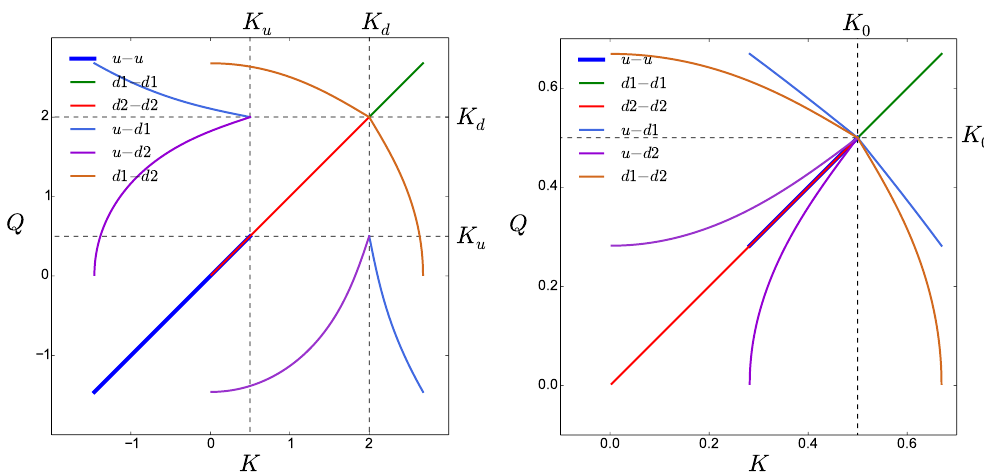
Figure 4: Zero temperature momentum space correlation lines from Eqs. (41), (42) and (43). These curves correspond to the loci of points with finite value of the two body momentum ( K , Q ) . They are labeled with the names of the modes of correlated correlation function G 2 momenta, for instance the “ u − d 1” curve corresponds to the line of correlation between the u | out and the d 1 | out modes. The left plot displays the results for a waterfall configuration = 0.5 and M = 4. The right plot displays the results for a flat profile configuration with M u d with the same values of M and M . The momenta are expressed in units of ξ − 1 u d